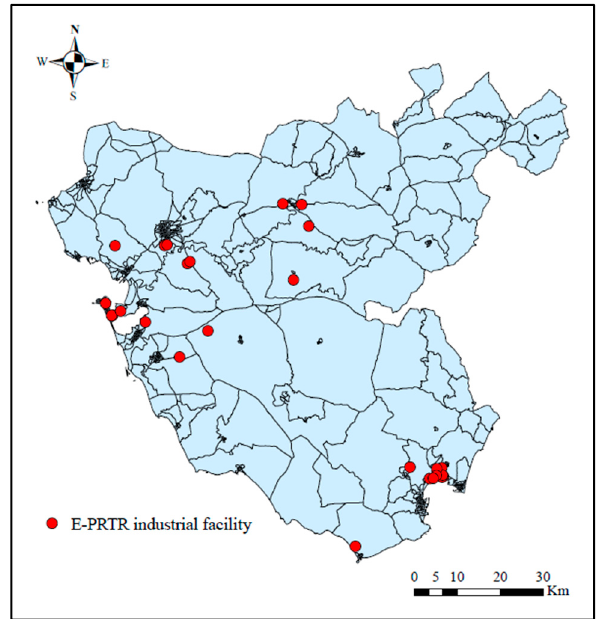
Figure 1. Locations of the 26 industrial facilities analyzed. E-PRTR—European Pollutant Release and Transfer Register.